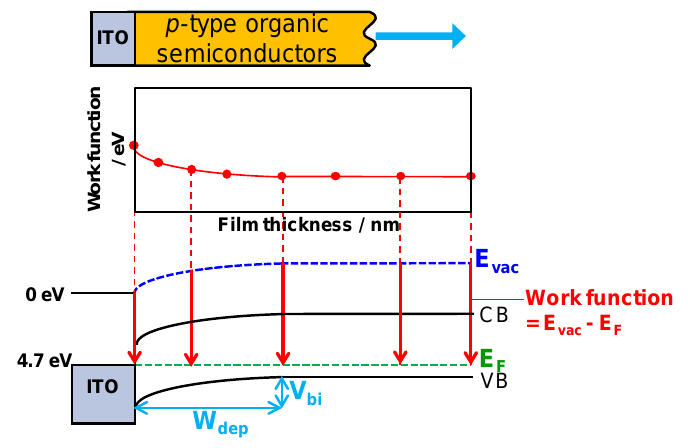
Figure 17. Principle of band-mapping by Kelvin probe. An interface between an ITO and a p -type semiconductor film is shown. Work function values (middle figure) corresponding to the double red arrows (lower figure) depending on the thickness of the organic semiconductor film were measured by Kelvin probe. E vacuum level, the Fermi level, the conduction band, and the valence band,